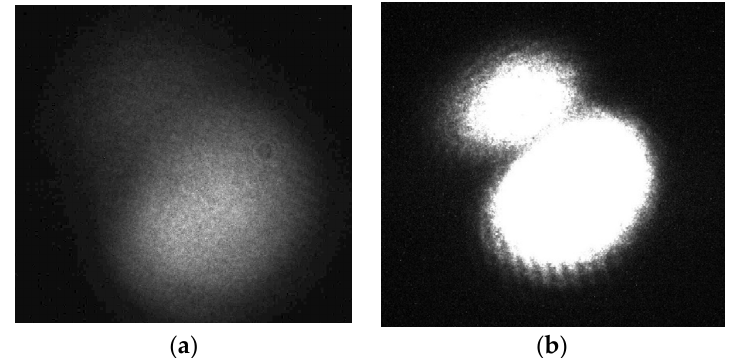
Figure 5. ( a ) Proper optical spot; ( b ) oversaturated optical spot. After the image collecting, data processing is required. In collected images, each pixel value range is from 0 to 255, representing the optical intensity of the original optical field.